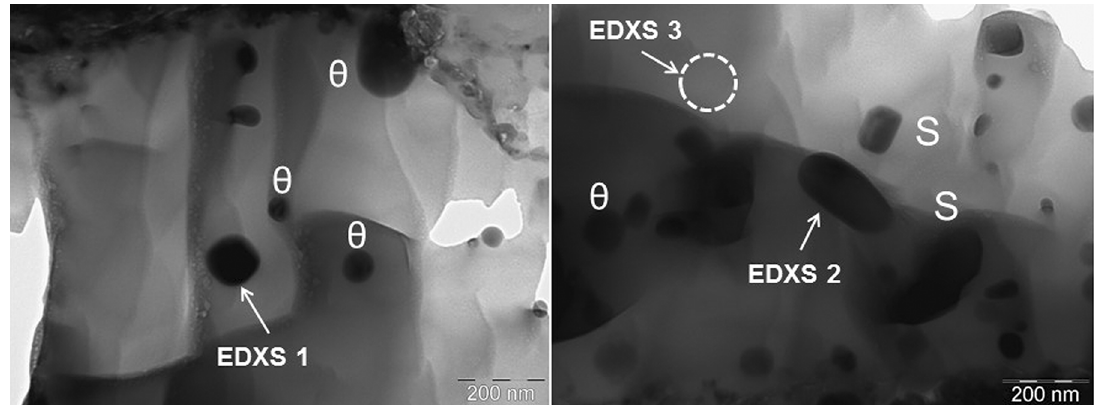
Figure 10. TEM analyses showing θ and S precipitates in the sample cryomilled for 8 h, degassed at 250 °C for 20 h, and then sintered.